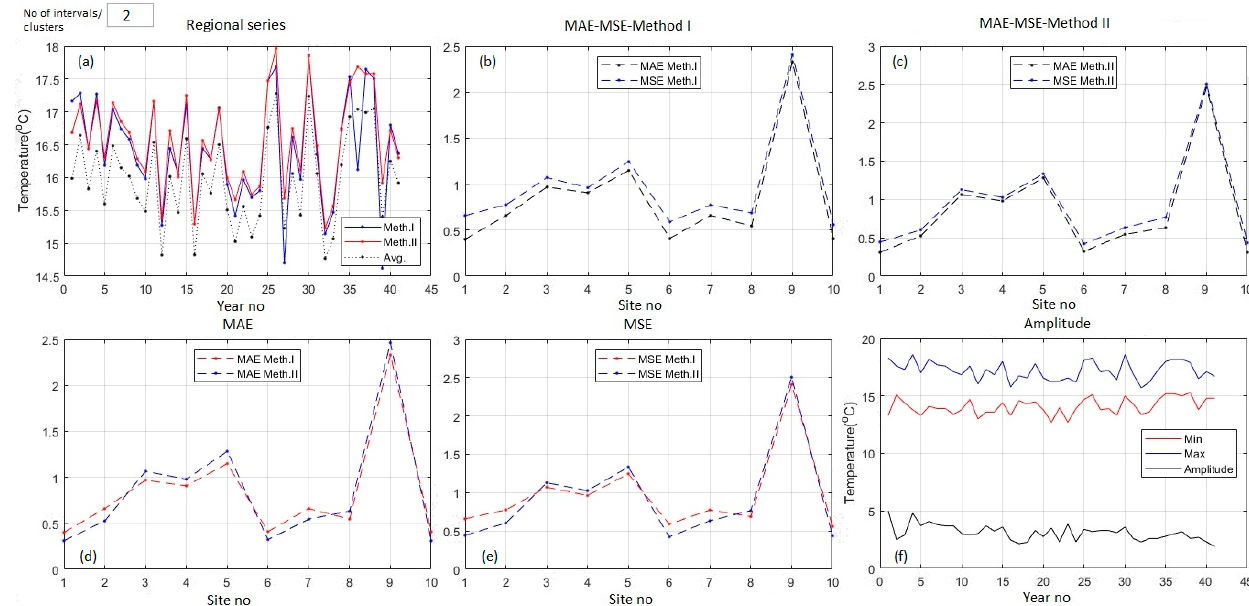
Figure 10. The case of two intervals/clusters for the series of maximum temperatures: ( a ) the regional series; ( b ) MAE and MSE—Method I; ( c ) MAE and MSE—Method II; ( d ) comparisons of MAEs; ( e ) comparisons of MSEs; ( f ) min, max, and amplitude of the average temperatures series.